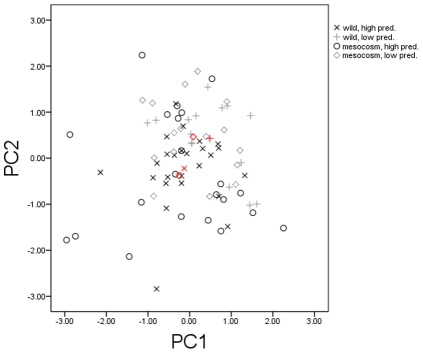
Scores generated by the behavioural performance PCA.Plotted according to the first two principal components. Red symbols represent group means.